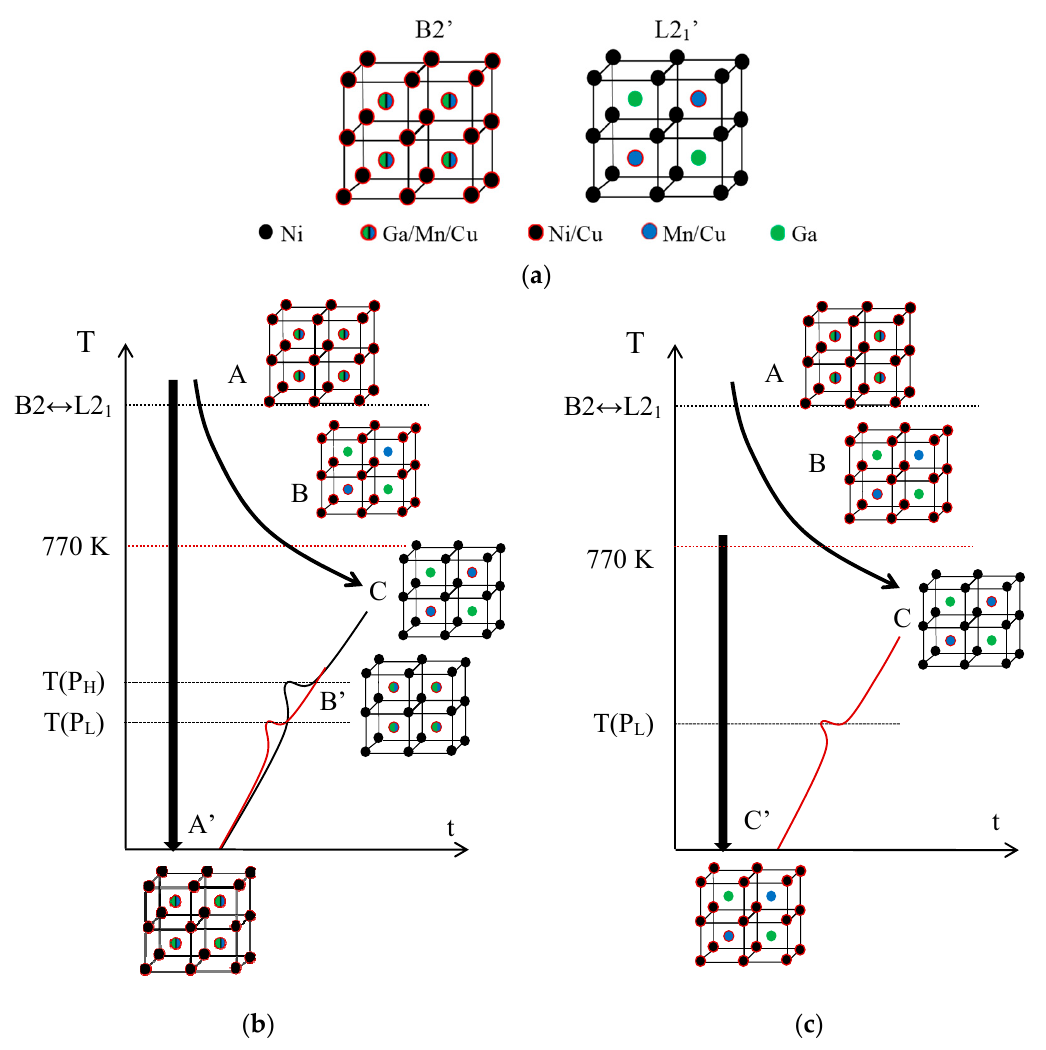
Figure 3. Crystal structure of the austenite with the proposed site occupation in each state of the sequences, as explained in the text. ( a ) Atomic occupancies for B2 ′ and L2 1 ′ order in Ni 2 Mn 1 − x Cu x Ga alloys. Sequences of ordering after quench ( b ) from the B2 ′ temperature domain; and ( c ) from below the B2 ↔ L2 1 temperature.